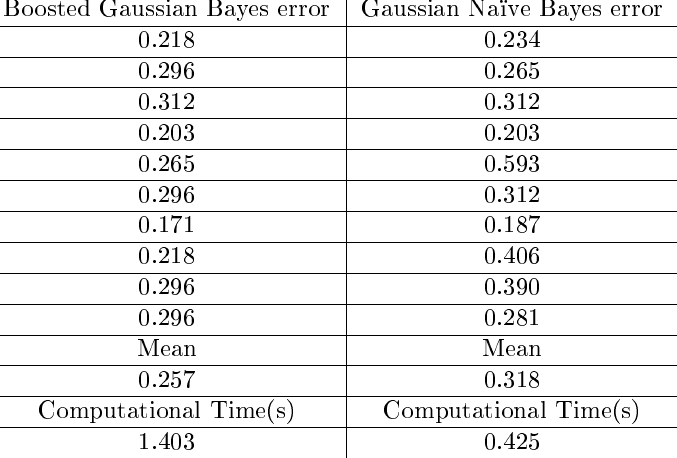
Table 2. Comparison of the results.